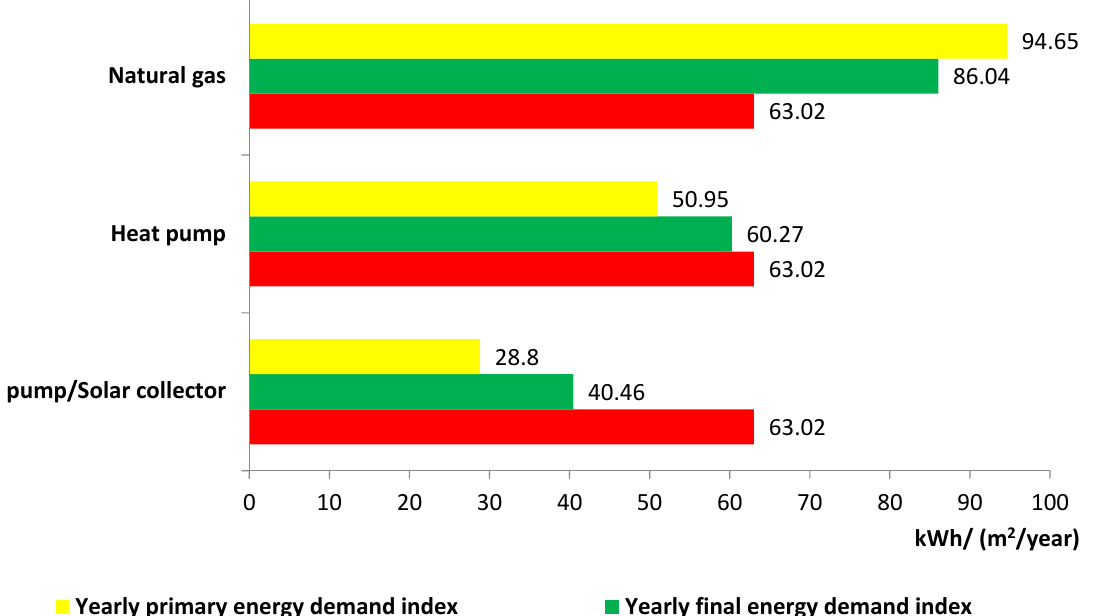
Figure 4. Energy performance indices of the analyzed building (data in kWh/(m 2 /year)). Source: own elaboration based on data from Tables 3–5 [38,39].